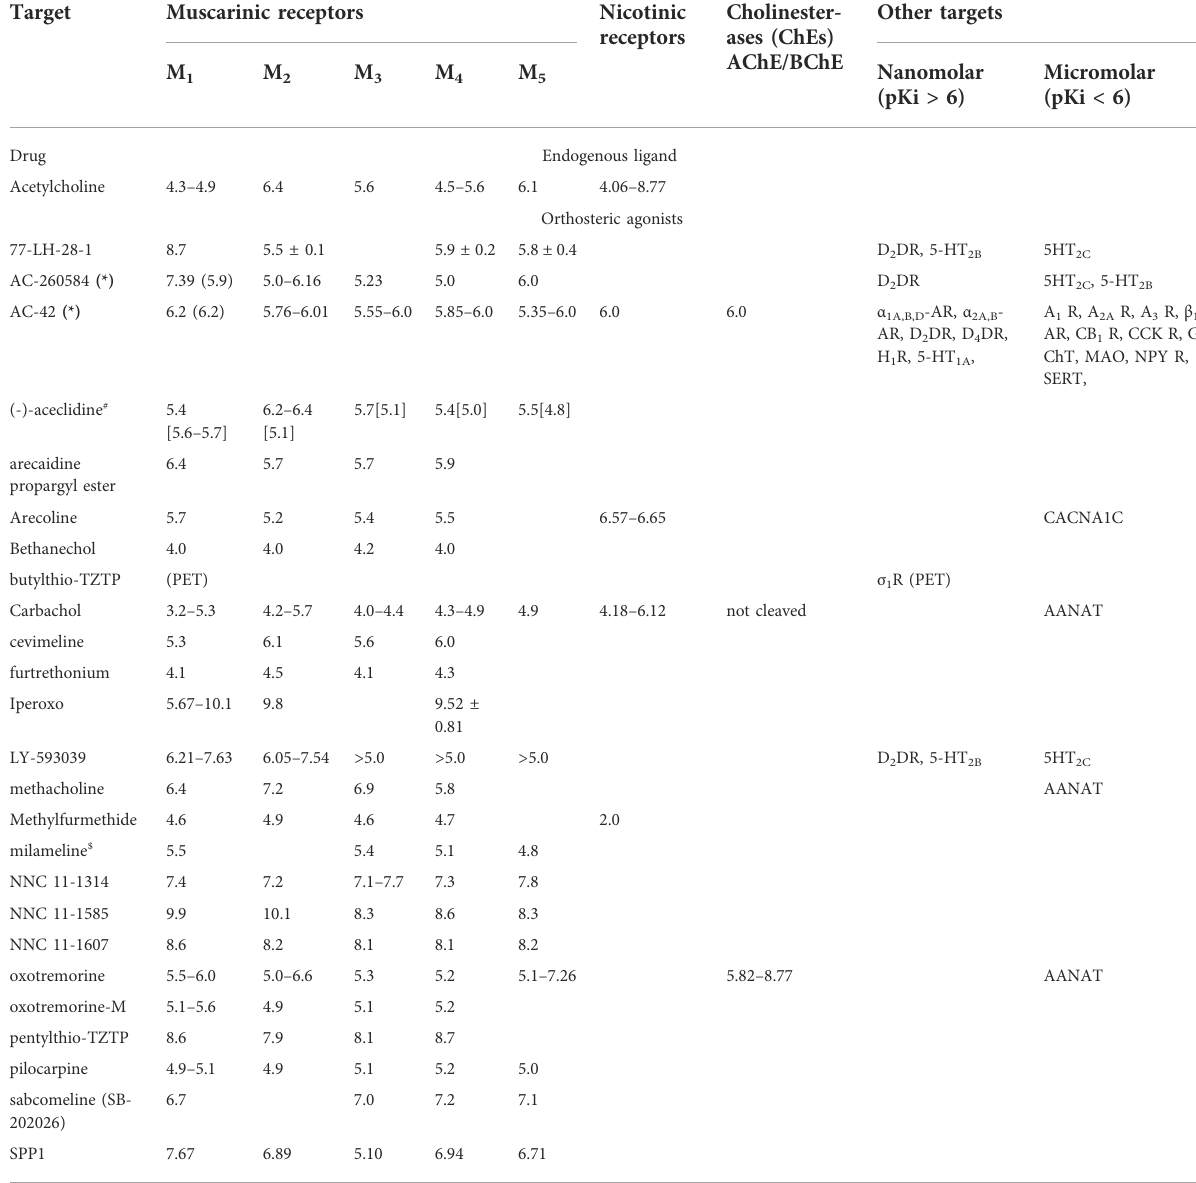
TABLE 1 Effects of orthosteric agonists (+endogenous ligand) on muscarinic receptors and other targets. The compounds are listed alphabetically. The numbers indicate pKi values. Please note that a higher pKi indicates higher af fi nity. Unavailable data are shown as blank spaces. The af fi nities of nicotinic receptors are not divided among speci fi c subunits. The af fi nities of other, noncholinergic targets are divided into nanomolar (pKi > 6) and micromolar(pKi < 6)groups.ThecategorizationofpKiiscompromisebetween extremely largeTableandfastorientation